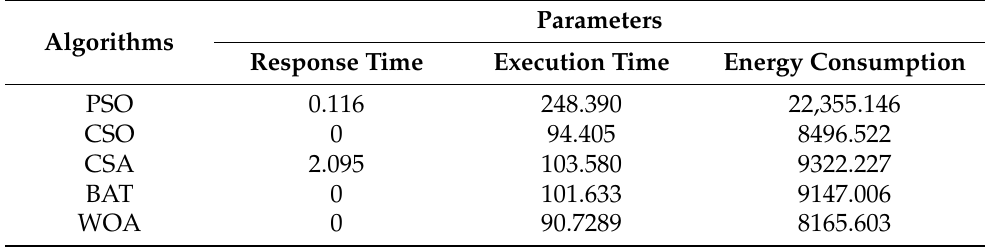
Table 2. Comparison of the proposed algorithm with the other implemented algorithms.